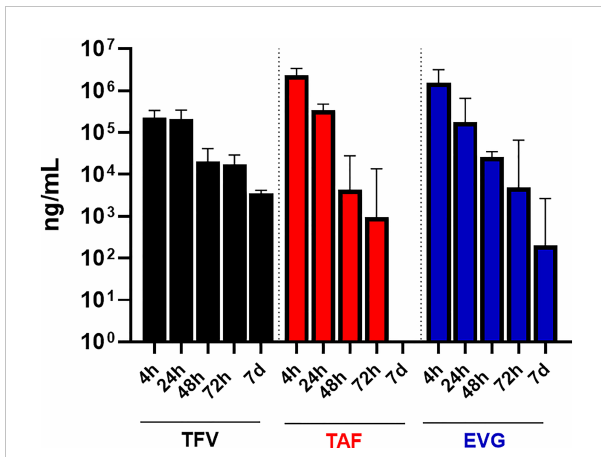
FIGURE 2 TFV, TAF and EVG in Vaginal Fluid. Black = TFV concentrations in ng/mL; Red = TAF concentrations in ng/mL; Blue = EVG concentrations in